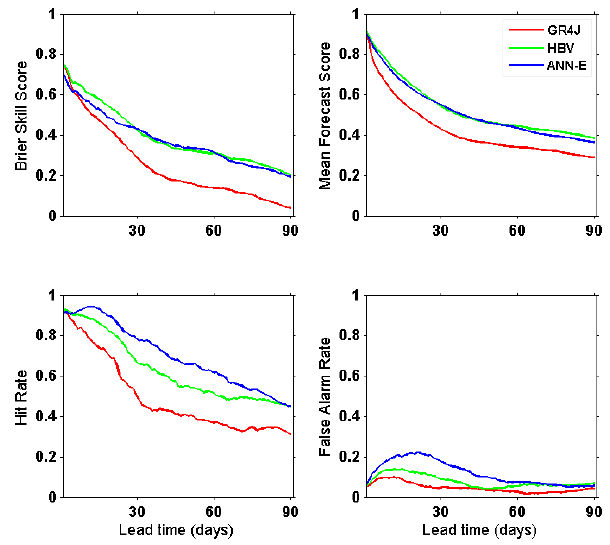
Figure 7. Skill scores for forecasting low flows at different lead times for three different hydrological models for the test period 2002–2005. Note that all forecasts (including high- and low-flow time steps) are used to estimate these skill